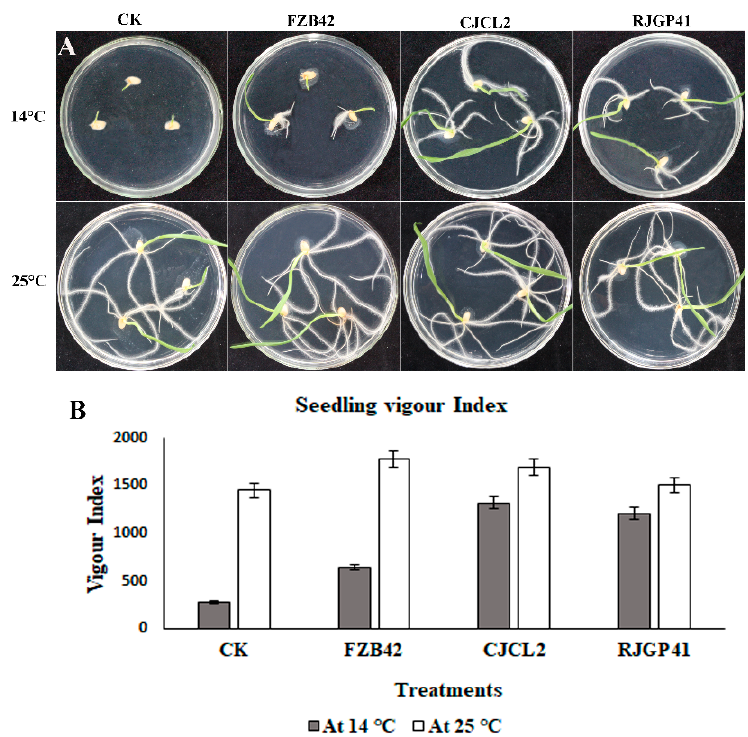
Figure 7. The wheat seeds grown for 7 days at 14 °C and 25 °C upon inoculation with strains FZB42, CJCL2, and RJGP41 ( A ). The measure of seedling length and percent germination given as a graph of seedling vigor index of inoculated seeds in comparison to control ( B ).